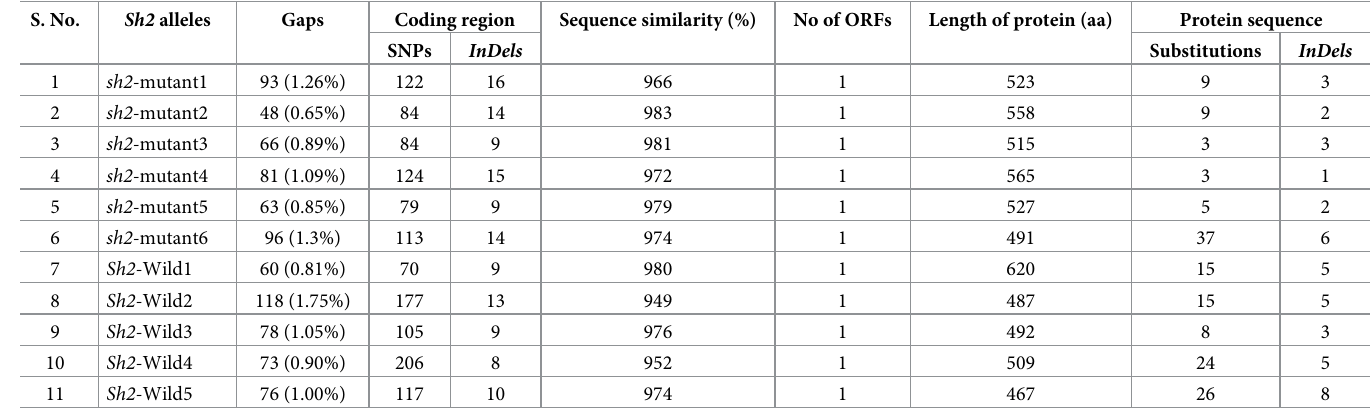
Table 3. Polymorphic data in comparison with Sh2 -Wild-M81603 coding region and SH2